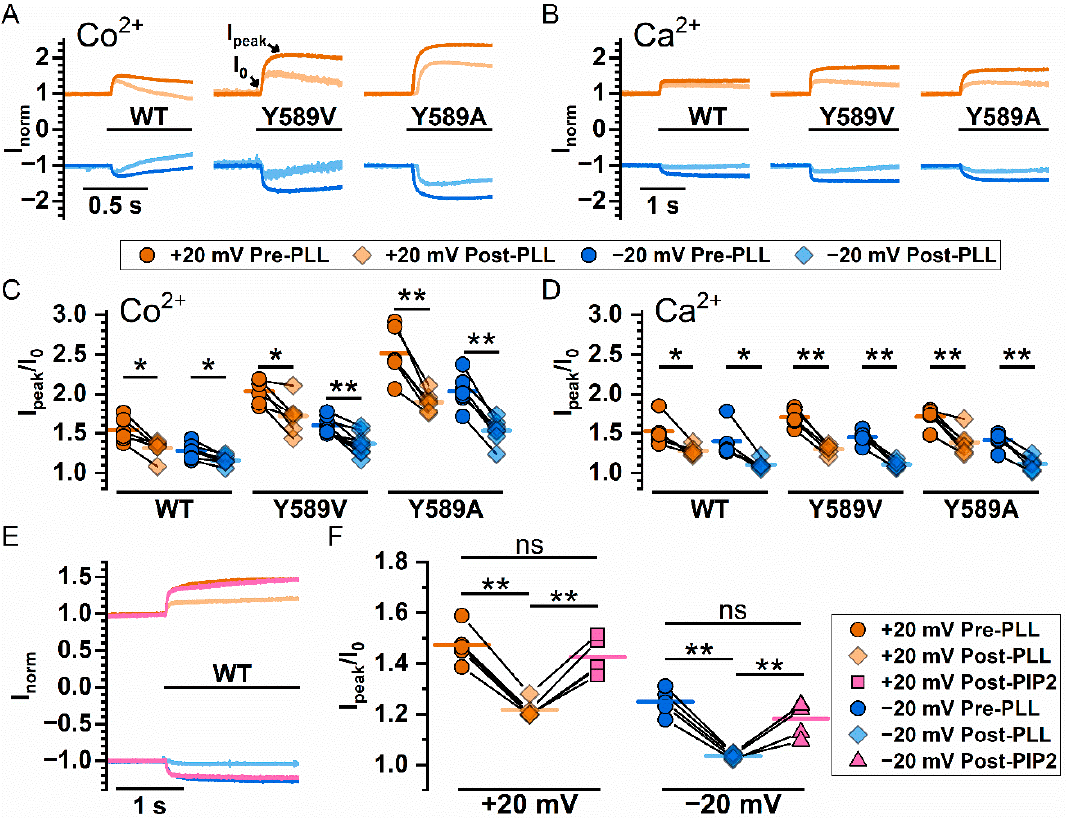
Figure 3. Manipulating Co 2+ and Ca 2+ potentiation of WT 16A , Y589V 16A , and Y589A 16A by intracellular reagents that affect membrane phospholipids. ( A , B ) Representative recordings showing Co 2+ and Ca 2+ potentiation, respectively, before and after treating the patch with poly- L -lysine (PLL, 0.3 mg/mL) for 5 sec. All currents were induced by 0.3 mM [Ca 2+ ] i and potentiated with an additional 20 mM Co 2+ or Ca 2+ (black bars underneath phenotype labels). ( C , D ) Degree of Co 2+ and Ca 2+ potentiation, respectively, before and after poly- L -lysine treatment. Orange (+20 mV) and blue ( − 20 mV) circles are the potentiation before poly- L -lysine treatment while light orange (+20 mV) and light blue ( − 20 mV) diamonds are the potentiation after poly- L -lysine. ( E , F ) Effects of PIP2 for reversing the effect of poly- L -lysine on the Ca 2+ -induced potentiation of the WT 16A current. Degree of Ca 2+ potentiation was measured before poly- L -lysine treatment, after poly- L -lysine treatment, and after PIP2 treatment. In ( C , D , F ), data points from the same patch are connected by solid lines, and colored horizontal line segments represent the mean of the data set. ns p > 0.05; * p < 0.05; ** p < 0.005 by one-way ANOVA followed by Bonferroni’s multiple comparisons.